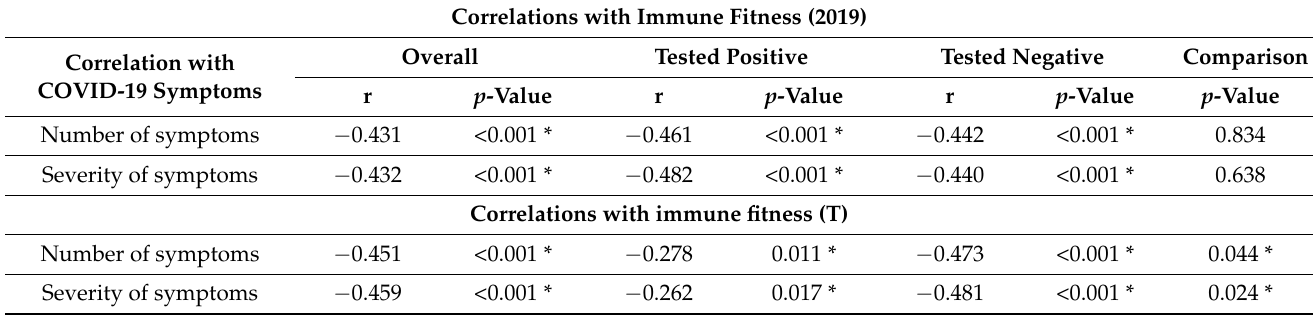
Table 3. Relationship of immune fitness and the number and severity of COVID-19